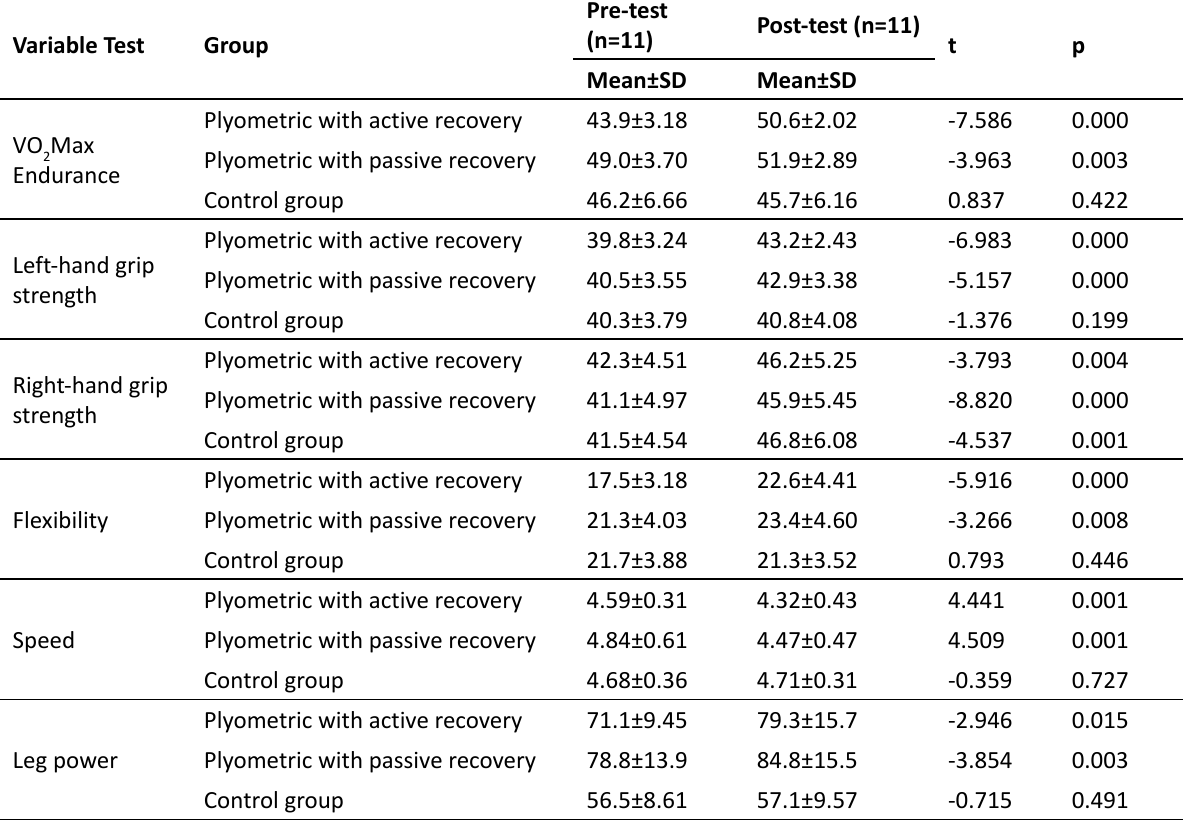
Table 2 . Parameter comparison of pre-test and post-test experimental group and control group